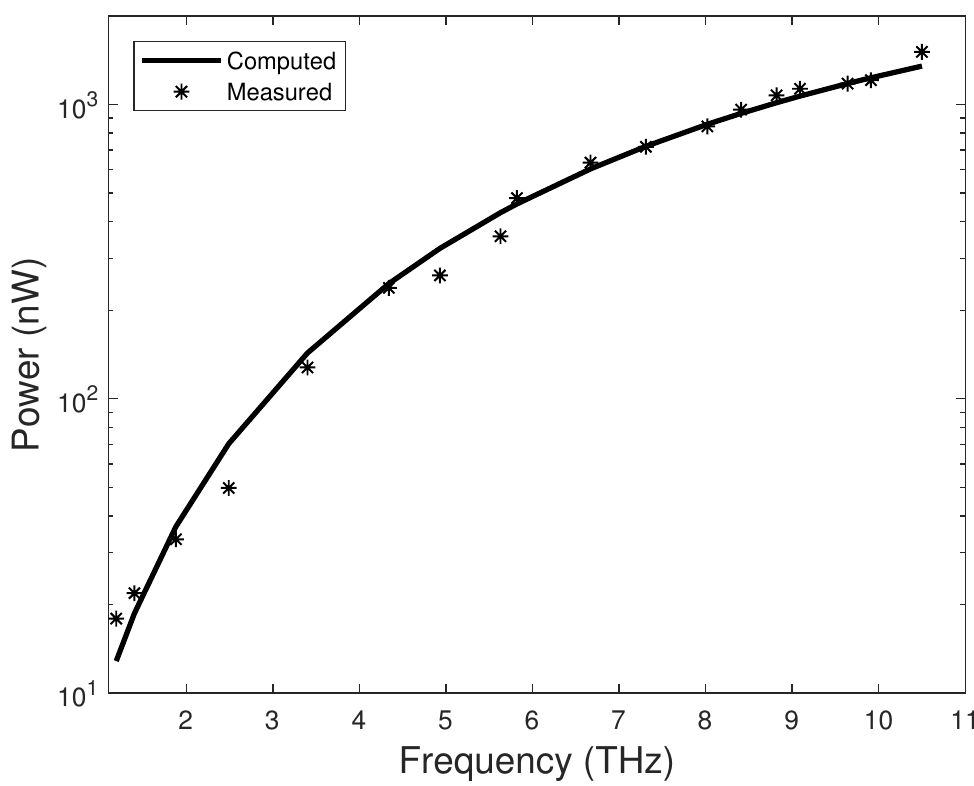
Figure 2. Expected and measured performances of the eighteen band pass